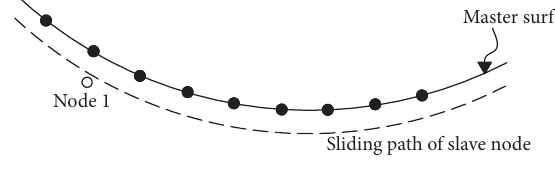
Figure 16: Path of finite sliding.